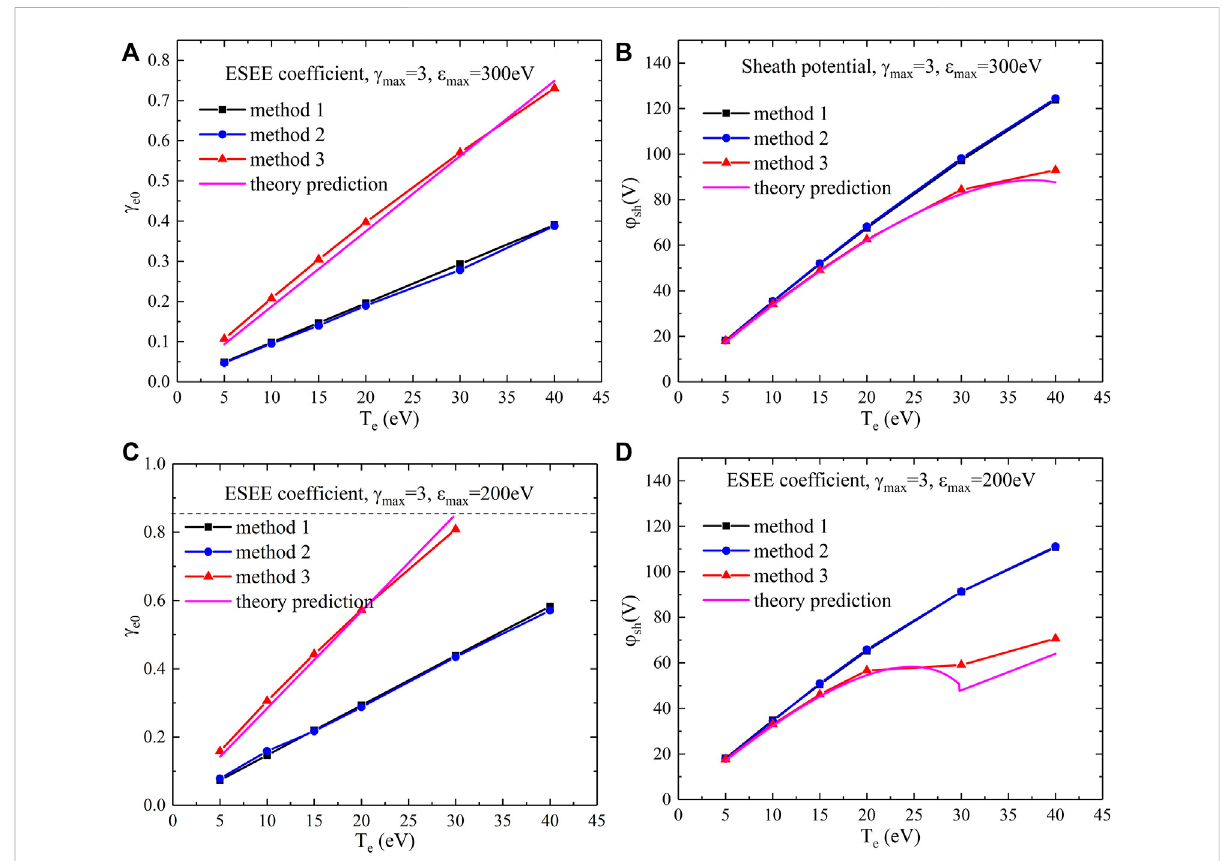
FIGURE 5 SEE coef fi cient and sheath potential calculated using three different γ e 0 setup methods obtained by simulation, in addition to the theory prediction. A series of plasma electron temperatures and two different ( ε max , γ max ) sets are applied. (A) – (B) ε max (cid:1) 300eV and γ max (cid:1) 3 and (C) – (D) φ ε max (cid:1) 200eV and γ max (cid:1) 3 ; (A) , (C) show γ e0 , and (B) , (D) show sh